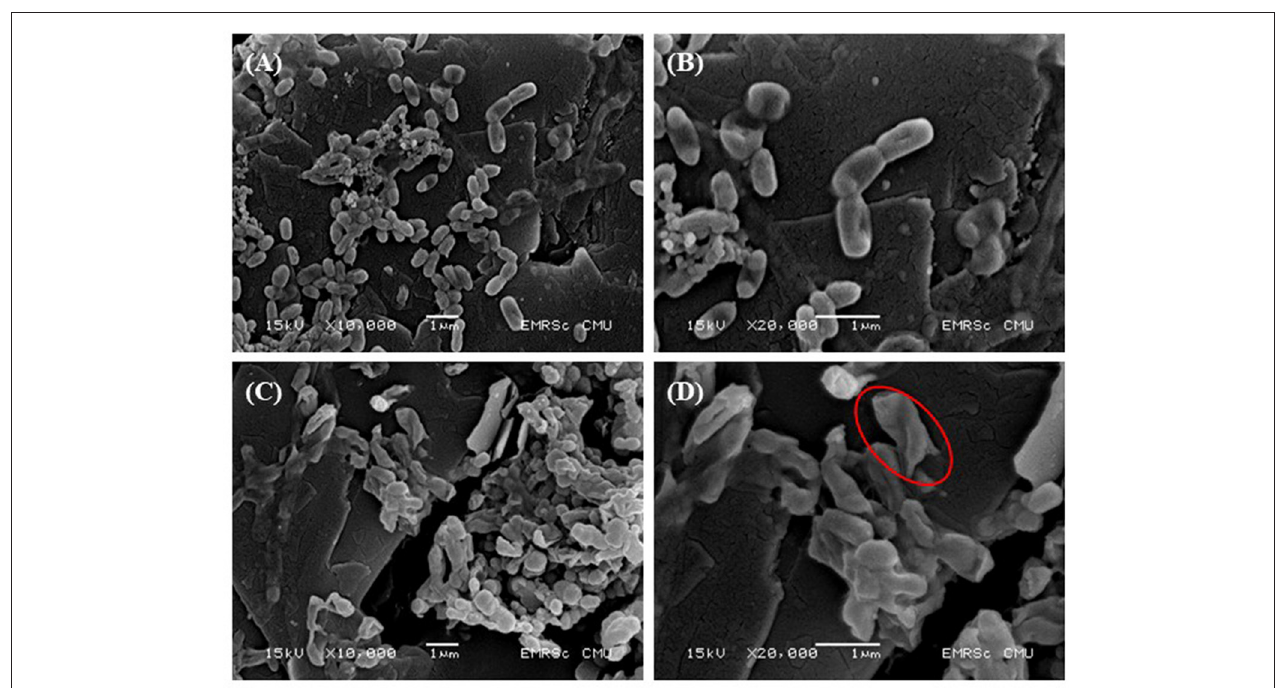
FIGURE 3 | Effect of CA on bacterial cell morphology. V. cholerae O1 El Tor N16961 was treated with CA at a concentration of 8 mg/mL for 2h at 37 ◦ C. SEM images at x10,000 and x20,000 magnifications were demonstrated. (A,B) Negative controls and (C,D) effective treatments. The cell membrane disruption is represented by the red